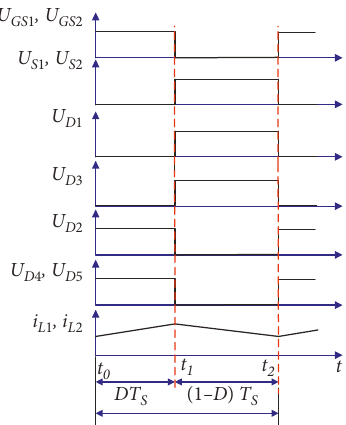
Figure 3: Switching condition and typical waveforms of